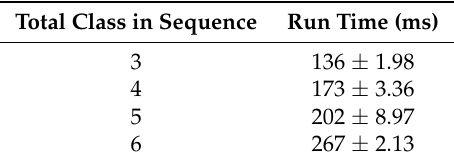
Table 9. Compact deep spatial pyramid pooling convolutional network classification in real-time (mean standard deviation of seven runs, 10 loops each) (with multi-GPU functionality; 2 ±